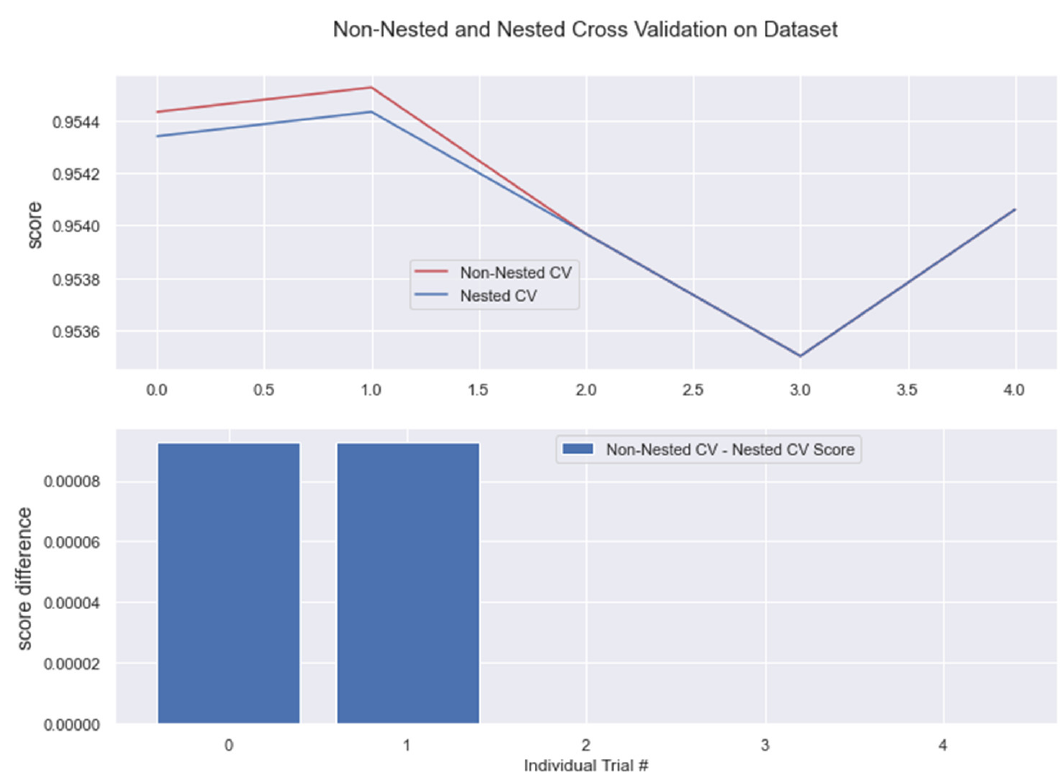
Figure 18. Non-Nested and Nested cross-validation on SVM algorithm.